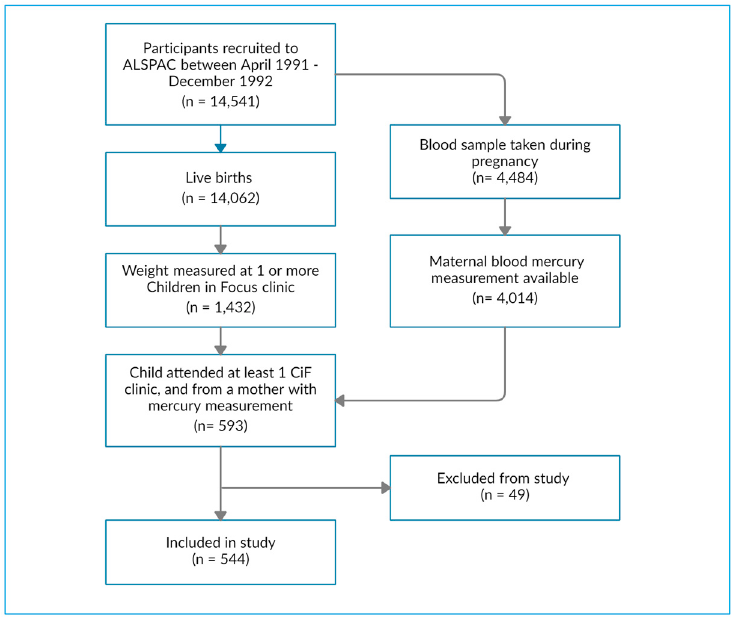
Figure 1. Flowchart of ALSPAC data available for this study.